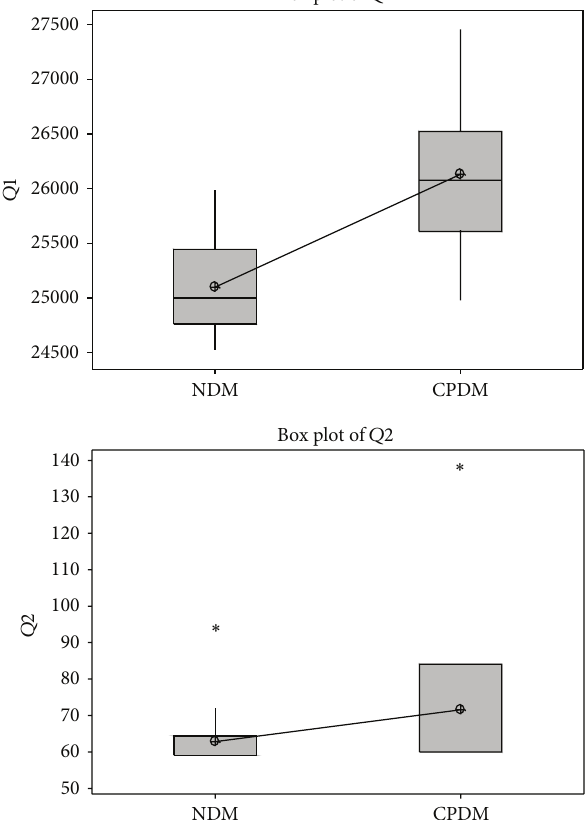
method. The competency of the proposed method was demonstrated, using the weight relative deviation (WRD) measure to compare the performance of the new defuzzi- fication method (NDM) and centroid point defuzzification method